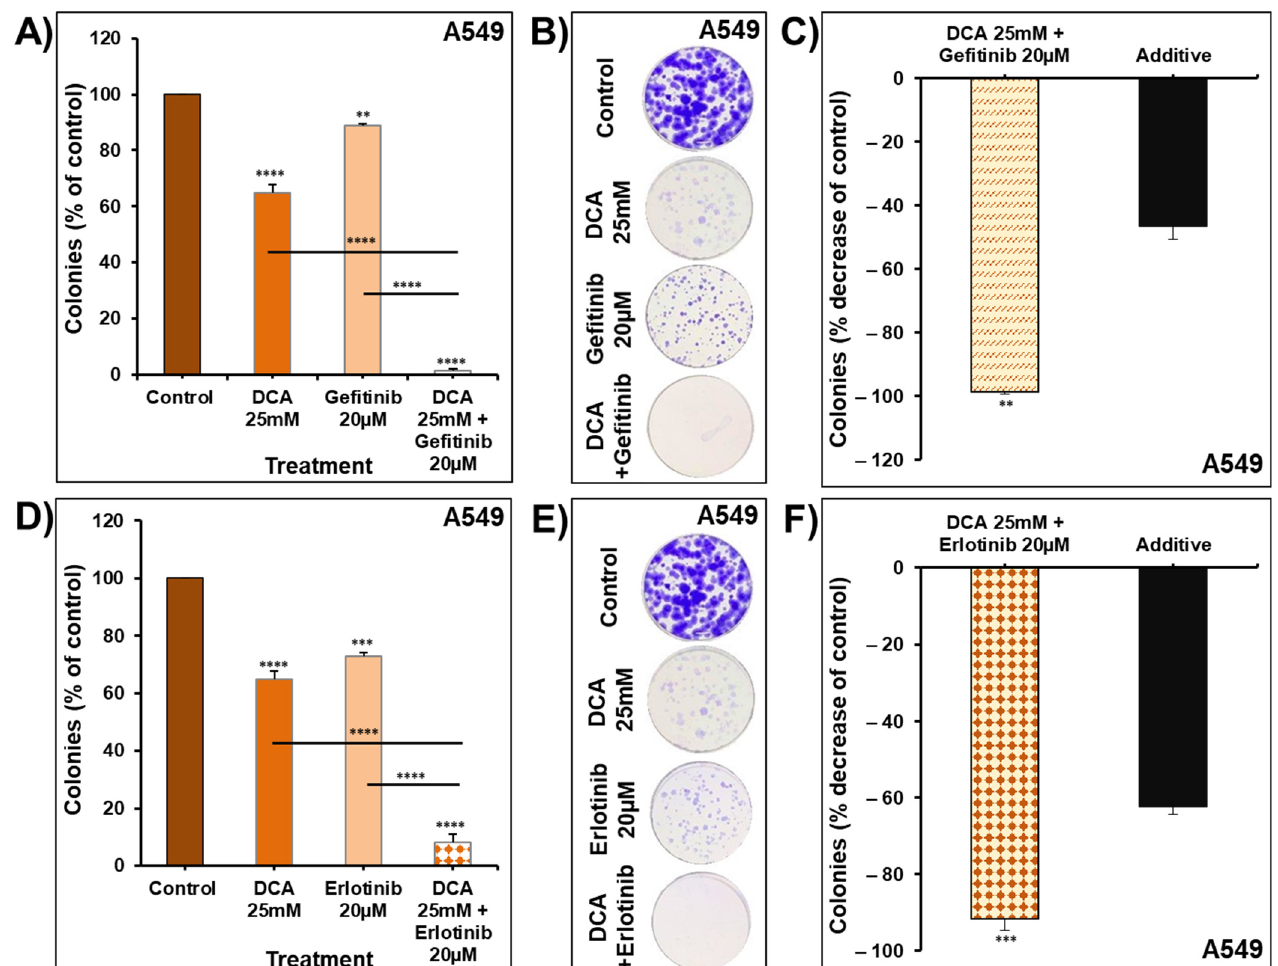
Figure 12. Effect of longer duration treatment with DCA in combination with gefitinib and erlotinib on A549 colony growth. Treatment of the pre-formed colonies of A549 with DCA (25 mM) ± gefitinib 20 µM ( A , B ) and DCA (25 mM) ± erlotinib 20 µM ( D , E ) for 14 days, after which colonies were fixed, stained and counted as described in the Materials and Methods. ( C , F ) Effect of combinations of DCA and gefitinib or erlotinib on colony growth compared with the calculated additive effects of the two drugs alone. All experiments were repeated 3 times. Columns are means; bars are S.E.M. ** Significantly different at <0.01. *** Significantly different at <0.001. **** Significantly different at <0.0001.